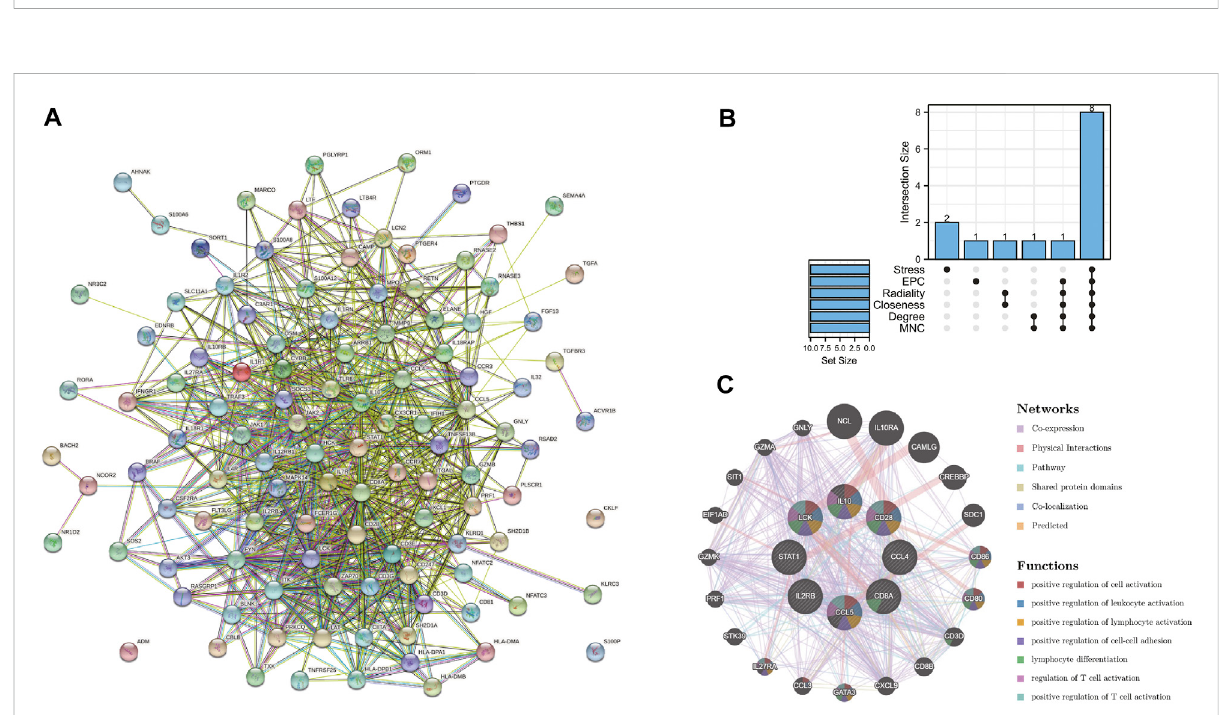
of all percentages of 24 in fi ltrating immune cells was de fi ned as the in fi ltration score. t -test was used to compare the differential immune cells between the disease group and the control